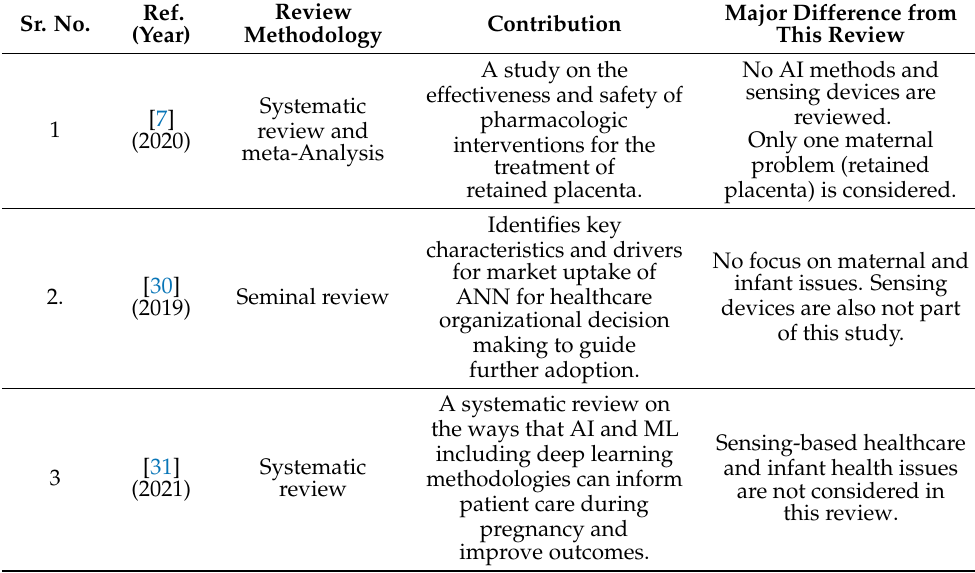
Table 1. A comparison of this review with existing review papers. Sr.